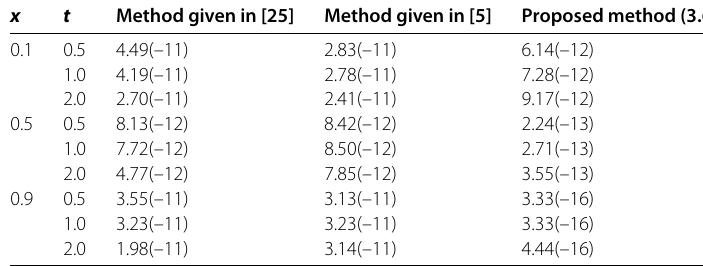
Table 8 Example 1: Case 1.3(b): Maximum absolute errors at δ = 2